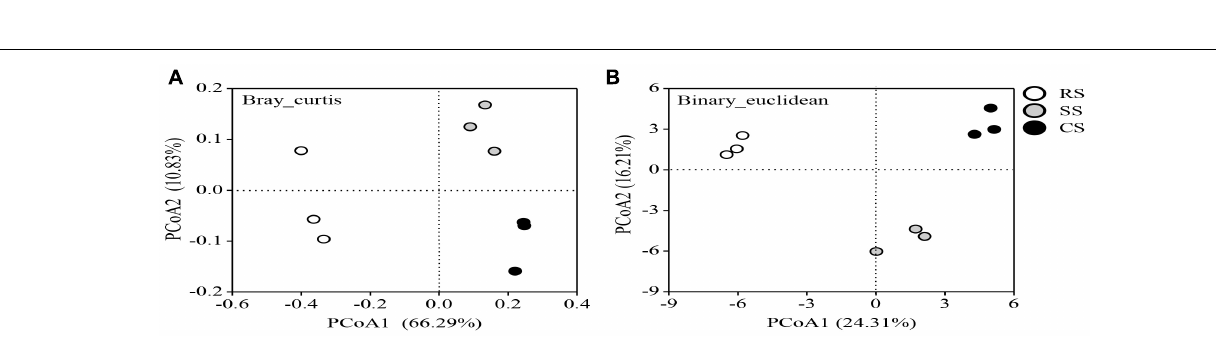
FIGURE 3 | Shannon index (A) and Chao 1 index (B) for fungi in three soybean cropping systems with > 97% sequence identity. ∗∗ P < 0.01 by Duncan’s test. RS, SS, and CS represented soybean rotation with a 3-year cycle of wheat, maize and soybean, short-term continuous soybean cropping with 1-year wheat and 2-year soybean, and long-term continuous soybean cropping, respectively.